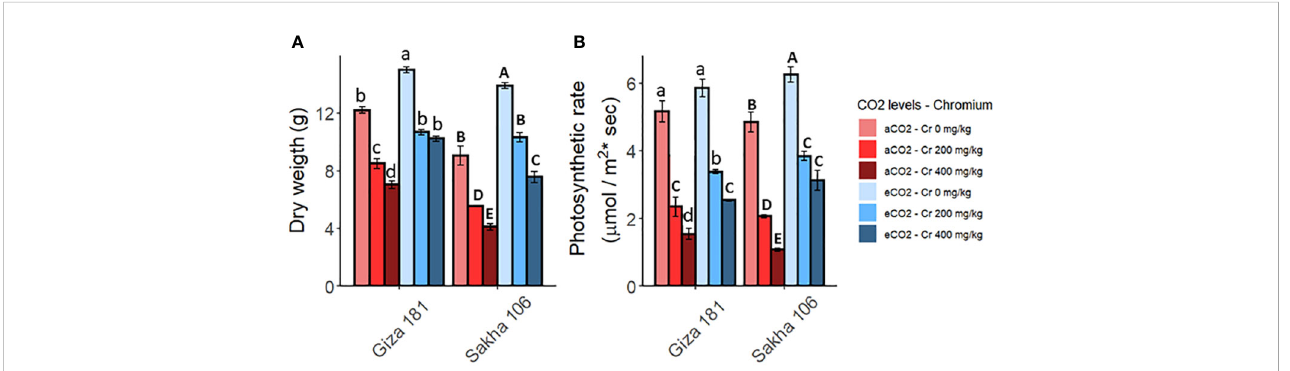
FIGURE 1 Effect of Chromium (Cr) exposure on dry biomass (A) and the rate of photosynthesis (B) in rice plants grown under either aCO 2 (410 ppm) or eCO 2 (620 ppm). Values are presented as means± standard error of 4 independent replicates. Different letters within the same cultivar represent signi fi cant differences between means (Tukey ’ s Test; P <